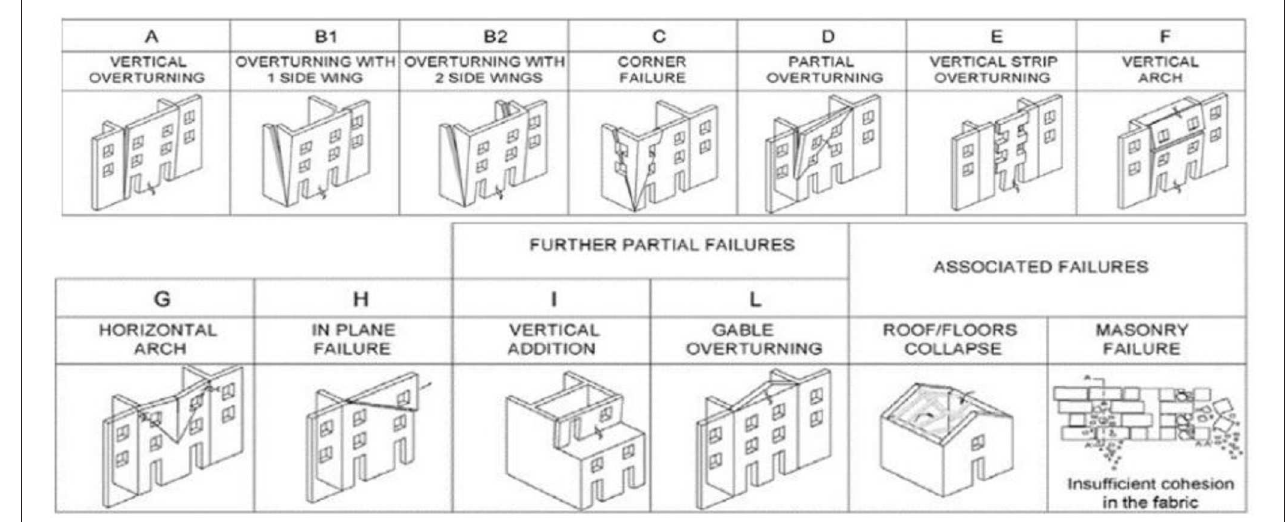
FIGURE 2 | The possible collapse